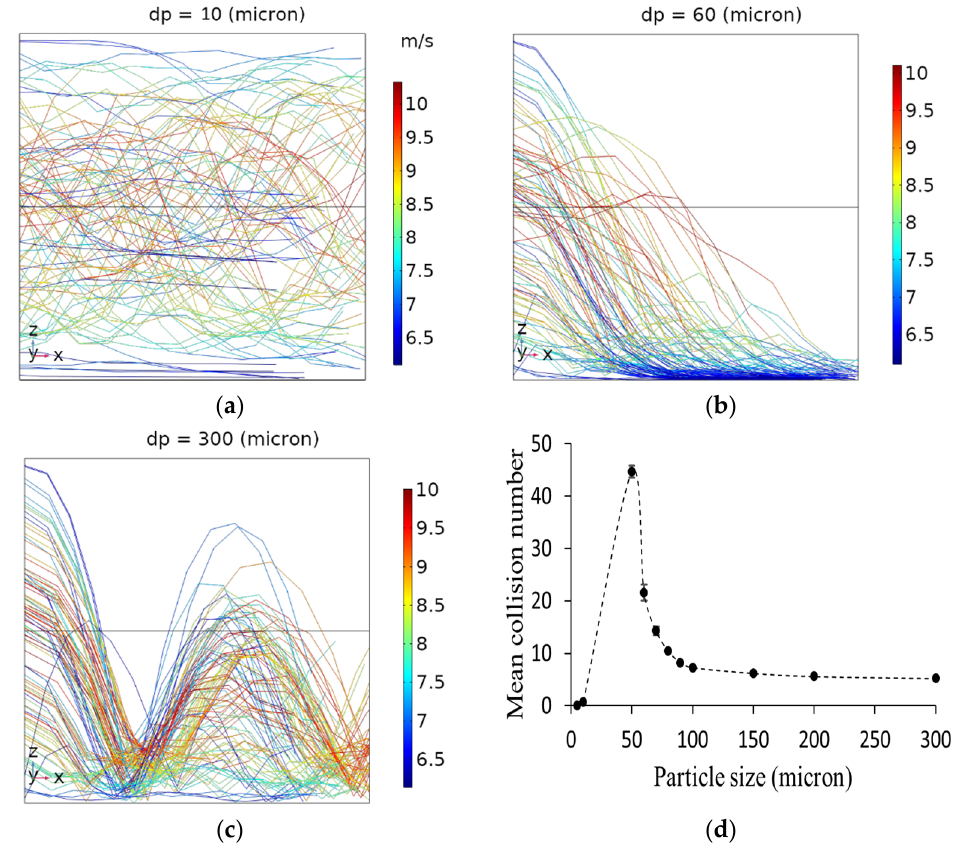
Figure 4. CFD analysis of particle trajectories for ( a ) low; ( b ) intermediate; ( c ) high Stk; and ( d ) influence of particle size on calculated particle-wall mean collision numbers. Particles were released into a 1 m pipe with a 4.76 mm inner diameter, and the air velocity was 8.4 (m/s). The color of trajectory lines shows the velocity magnitude (m/s) of particles. The x -axis points in the streamwise direction, the z -axis in the wall-normal direction, and the y -axis in the spanwise direction.